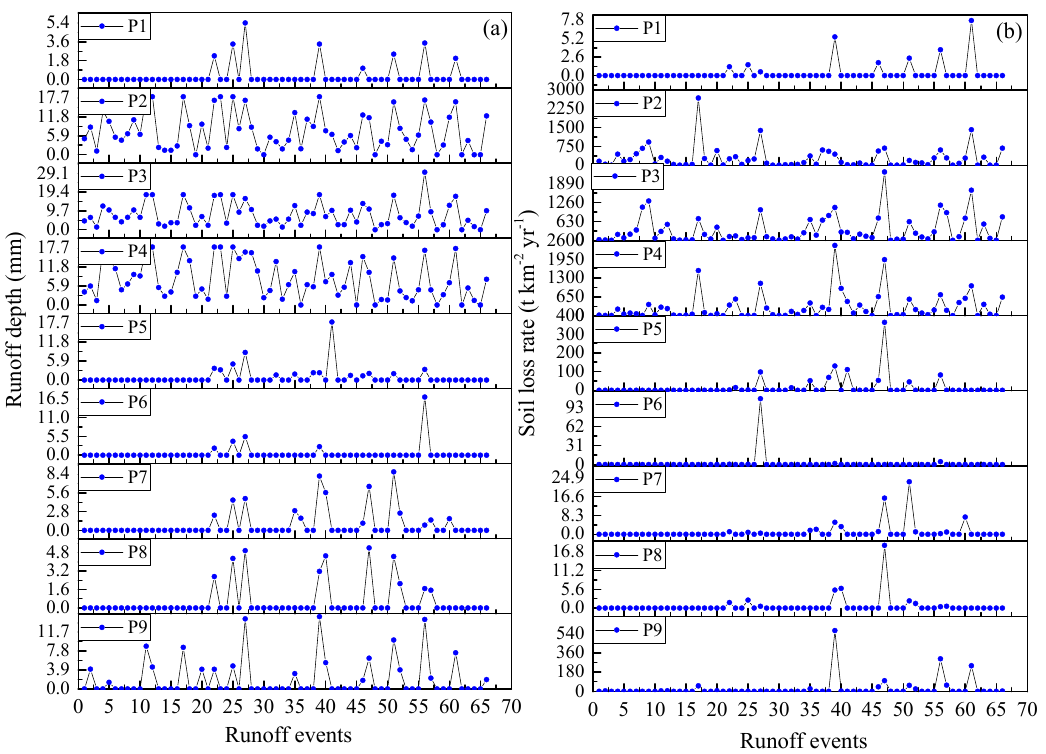
Figure 2. Temporal changes of runoff depth ( a ) and soil loss rate ( b ) during 2014–2020.